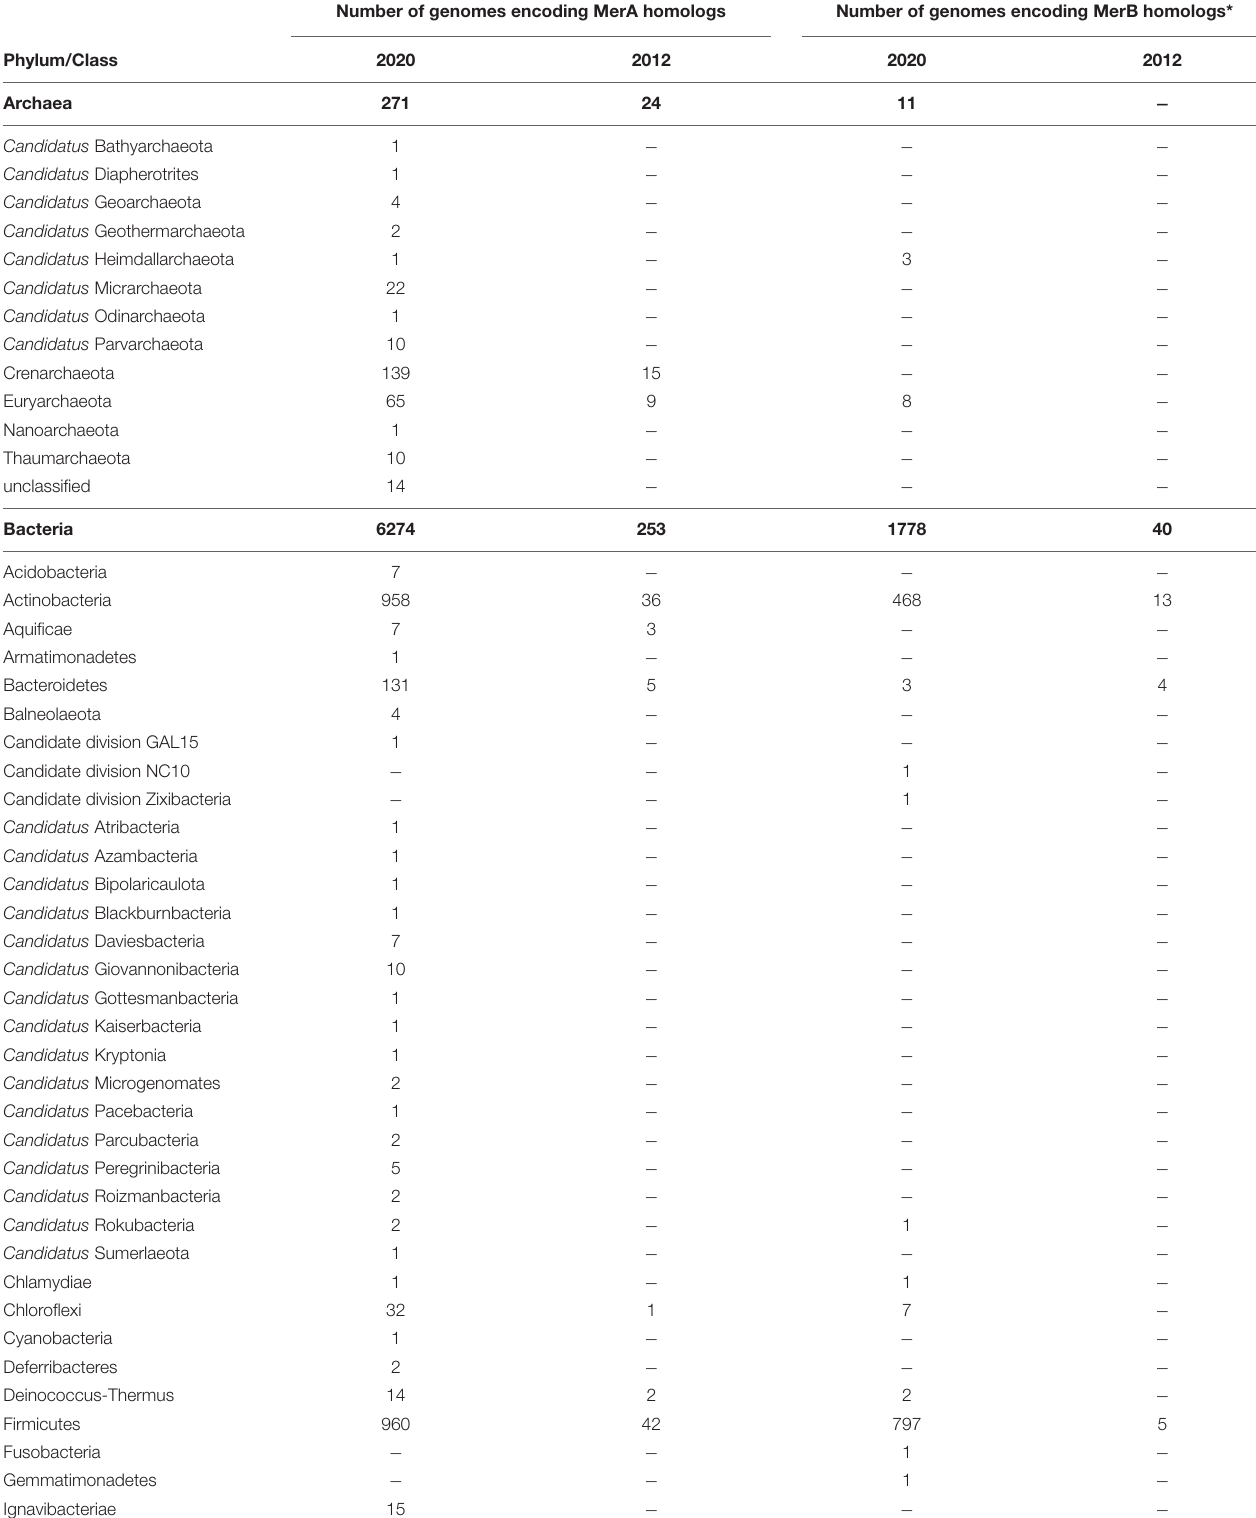
TABLE 1 | Number of genomes that encode MerA or MerB protein homologs and their distribution at the Phylum level in the database constructed in 2012 (Boyd and Barkay, 2012) and here in 2020. Number of genomes encoding MerA homologs Number of genomes encoding MerB homologs*